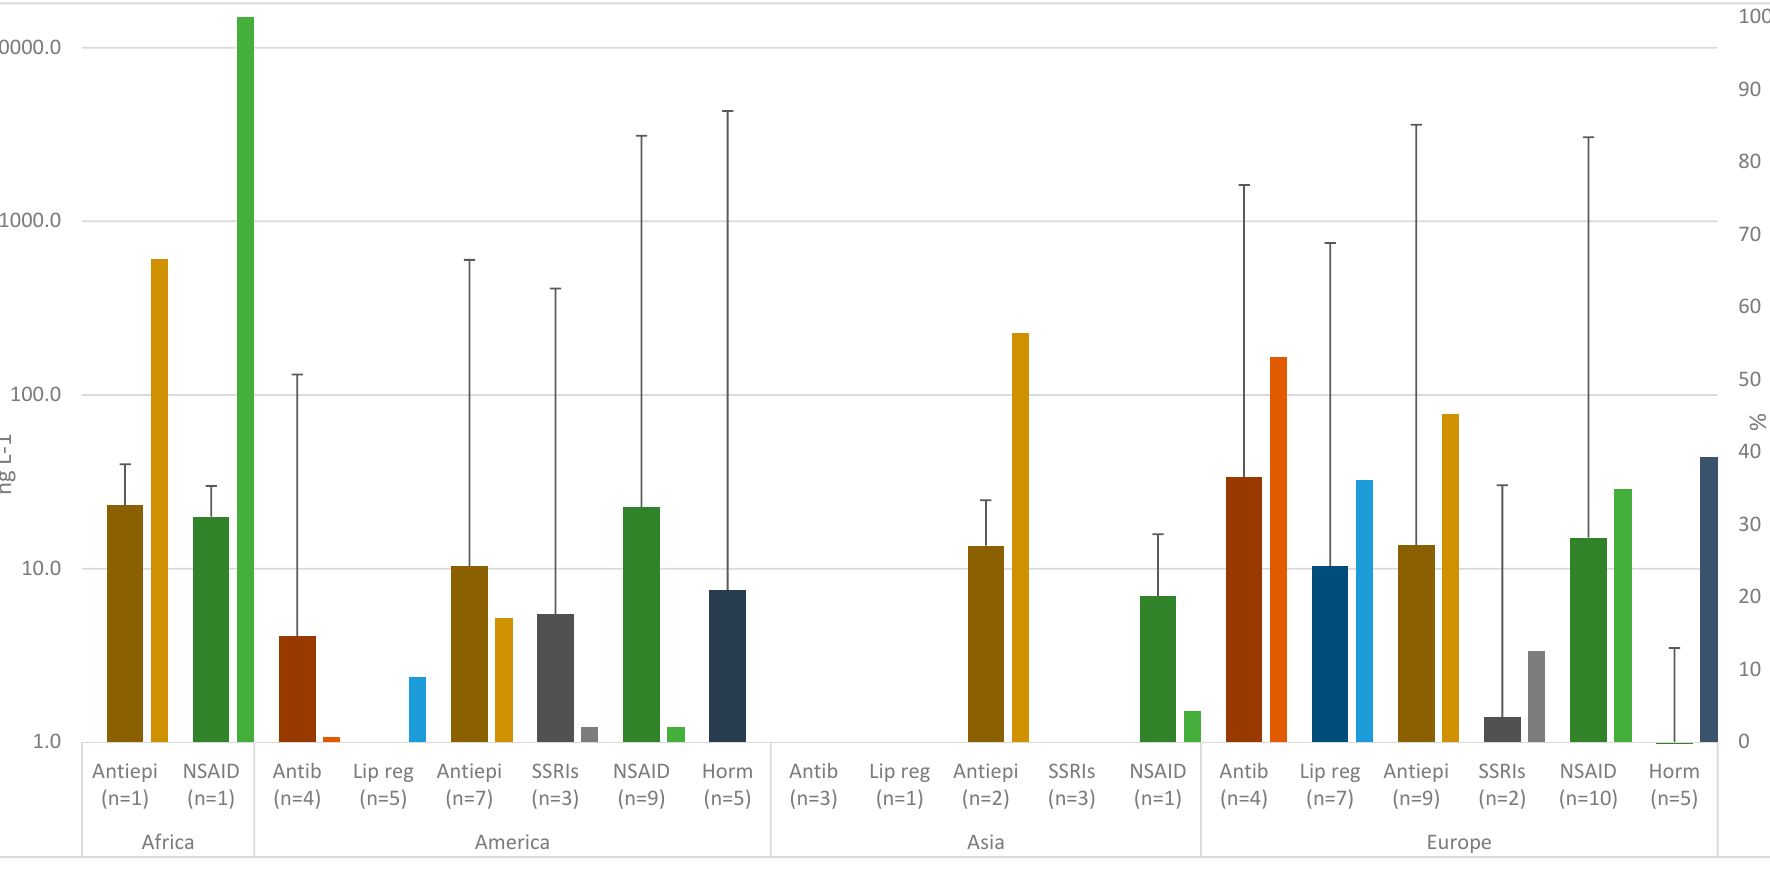
Figure 1. Median ( left column), maximum ( top wiskers) concentrations and detection frequencies ( right column) in drinking and groundwaters by continent. Antib—Antibiotics; Lip reg—Lipid regulators; Antiepi—Antiepileptics; SSRIs—Selective serotonin reuptake inhibitors; NSAIDs—Non-steroidal anti-inflammatory drugs; Horm—hormones [4,25,31–59].